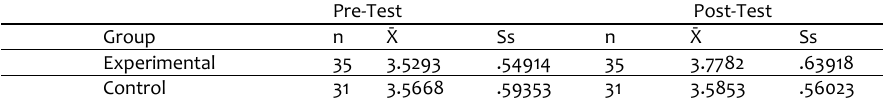
Table 2. Descriptive Statistics Results Related to Advanced Reading Awareness of Students